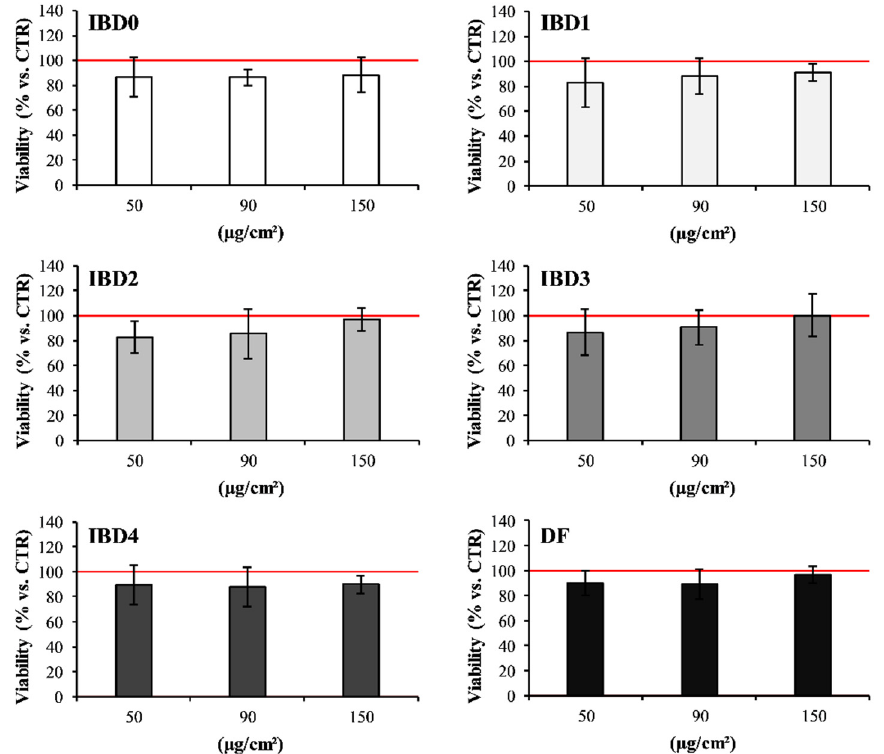
Figure 1. Intestinal 70% Caco-2 / 30% HT-29 co-culture viability after incubation with IBDs. The graphs in the figure represent the viability of intestinal co-culture cells after incubation with 50, 90, and 150 µ g / cm 2 of IBD0, IBD1, IBD2, IBD3, IBD4, and DF. The viability results are expressed as % vs. CTR (100), represented by the red line. Each % comes from the average of three independent experiments, each with at least two replicates.